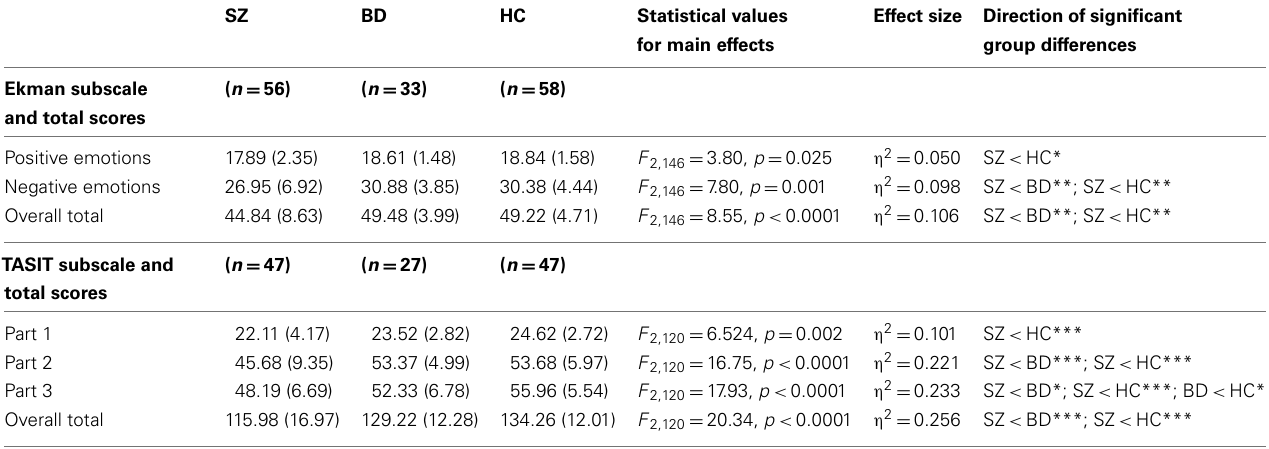
Table 2 | Means and SD for all groups on the social cognition measures. SZ